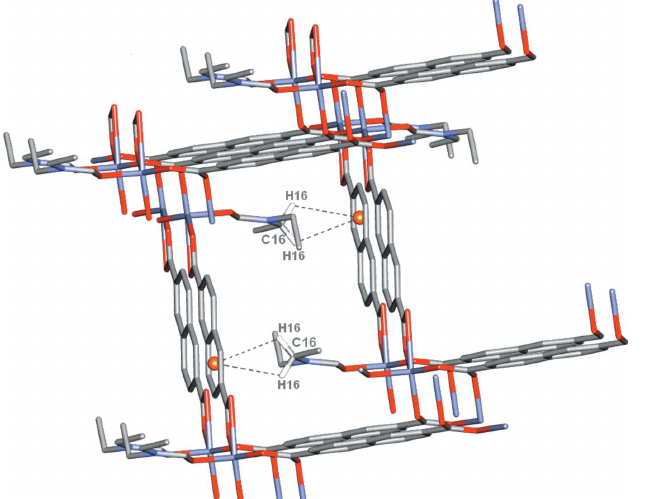
Figure 3 H centroid – (cid:5) interaction found in MOF 1 with DEF H atoms (H16) located near the centroid of the NDC 2 (cid:2) aromatic ring (all H atoms have been omitted for clarity, except for the DEF-H16 H atoms involved in the interactions).